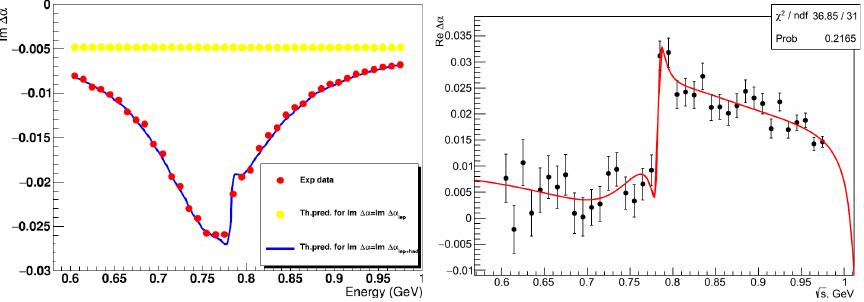
Figure 2. Left panel: Im ∆ α (s) extracted from the KLOE data [8] compared with the values provided by alphaQED routine [9, 10] (without the KLOE data) for Im ∆ α = Im ∆ α lep (yellow points) and Im ∆ α = Im ∆ α lep + ππ (blue solid line). Right panel: Re ∆ α ( s ) extracted by KLOE data (black points) with a fit (red line) [8]. Only statistical errors are